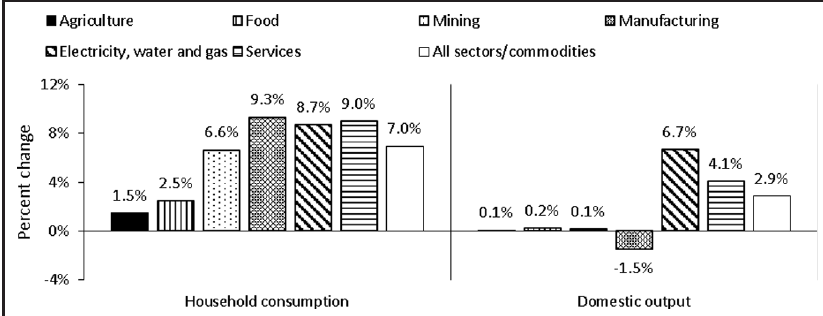
Change in household consumption and in domestic output